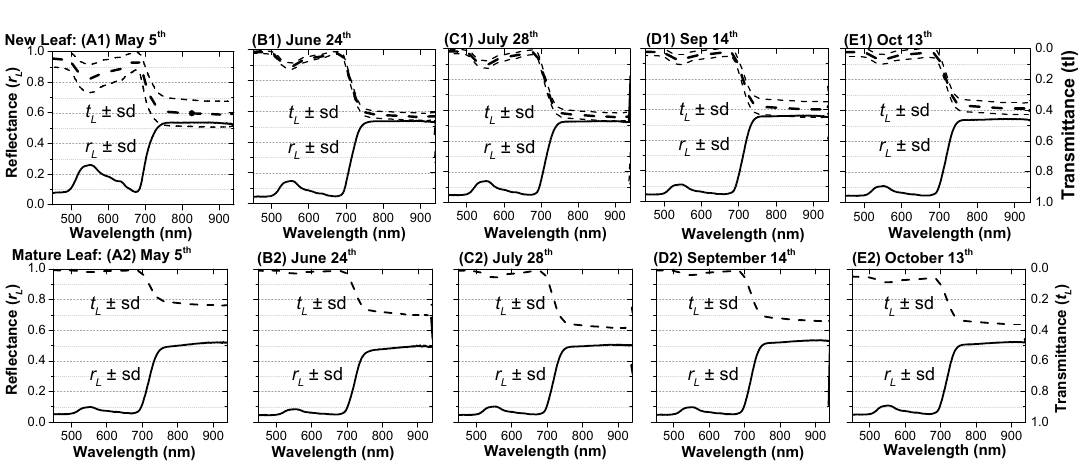
Figure 7. Field spectral curve data (mean ± 1 s.d.) in shortwave bands for new ( A1 – E1 ) and mature ( A2 – E2 ) needle samples ( n ) from Chinese fir collected on 5 May, 24 June, 28 July, 14 September and 13 October 2017. From May to October, n = 22, 15, 26, 30 and 39 respectively, and each sample includes 5 to 8 leaves. Reflectance data ( r L ) for each month are presented as the lower set of curves within each plot, while transmittance data ( t L ) are presented as the upper set of curves. Absorption characteristics are depicted based on the area between the upper and lower set of curves. SD values for new leaf t L are depicted in the upper and lower dash lines, to avoid overlap with r L , while SD values for all other r L and t L measurements are depicted in gray buffed